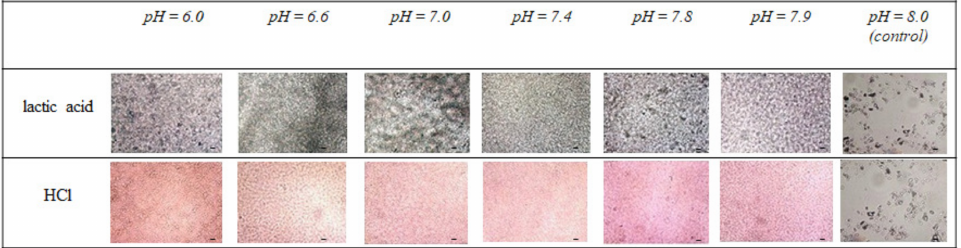
Figure 3. The formed cell suspension and induced morphological changes in the epithelial colon cancer cell line incubated for 48 h in a cell environment whose pH values were corrected with lactic and hydrochloric acids (magnification, 40 × scale bar, 50 µ